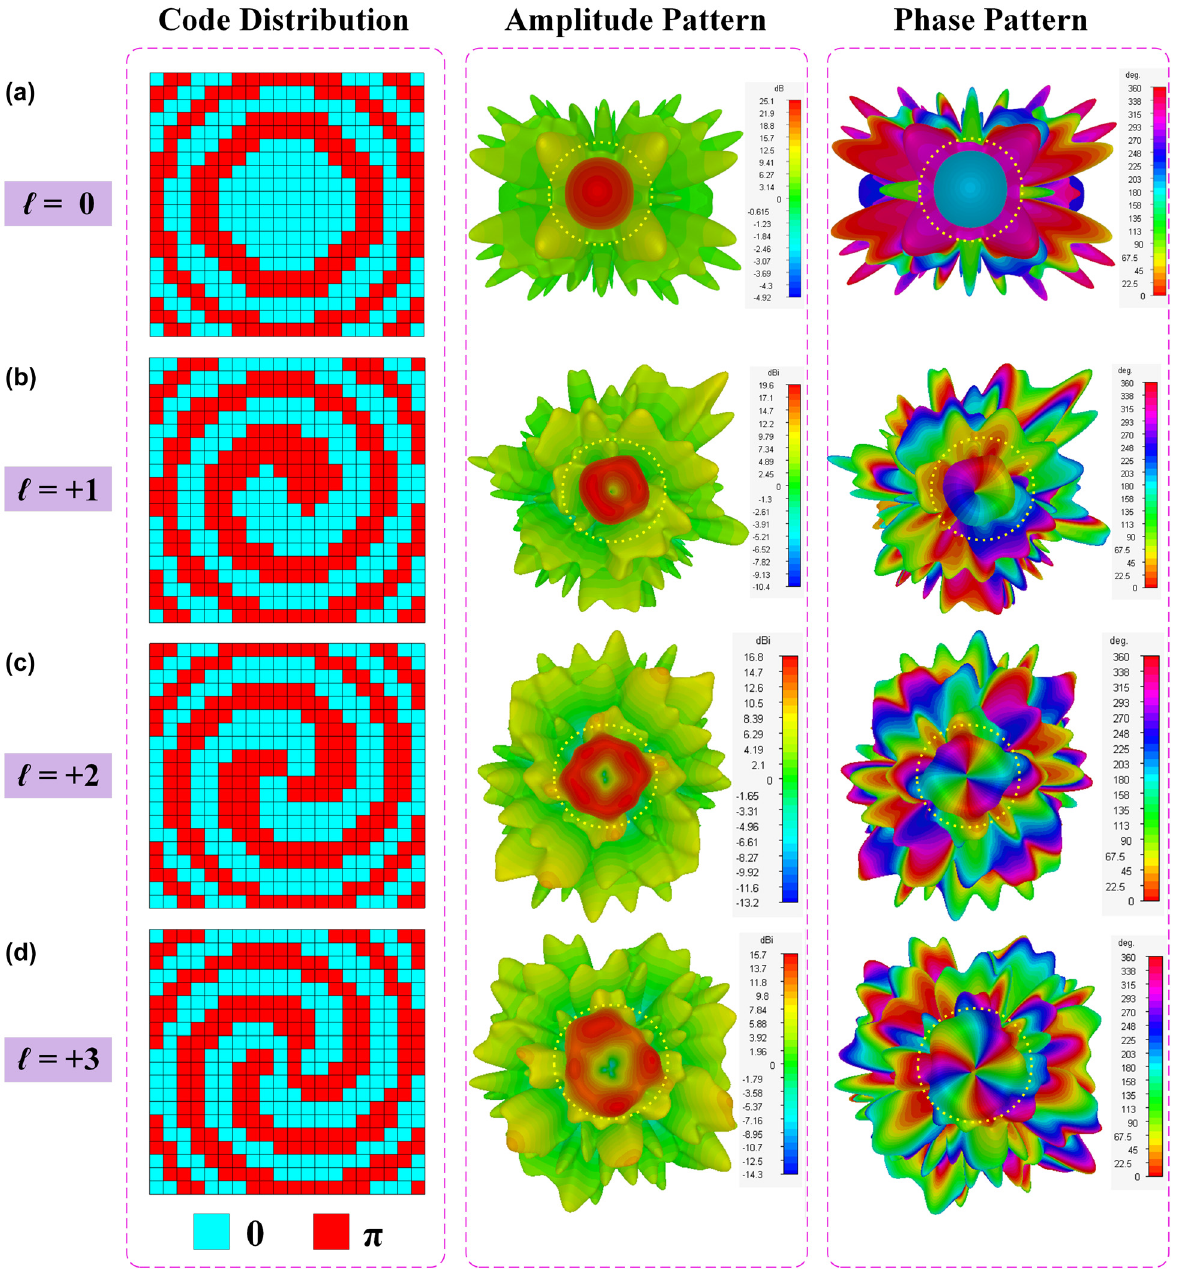
Figure 5: Code distributions and simulated radiation patterns for different OAM